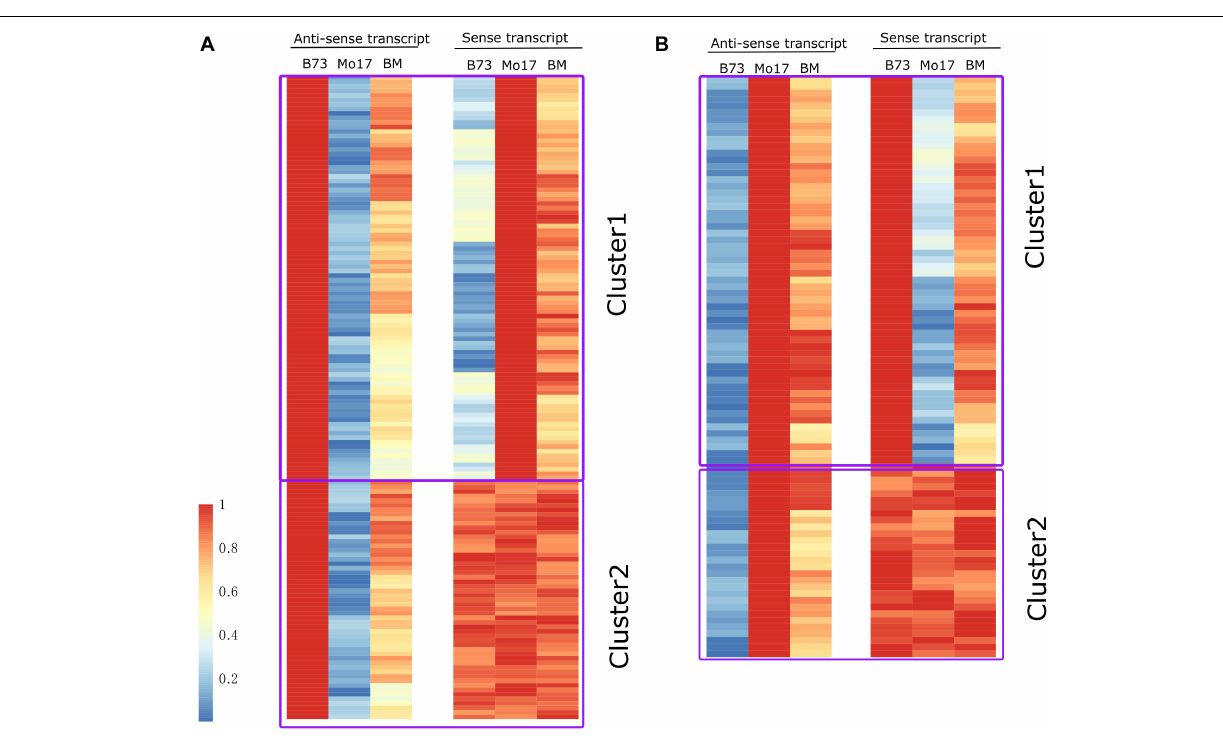
FIGURE 4 | Dynamic pattern of single-parent expression of anti-sense (SPEA) and its cognate sense RNA identified in leaf tissue in three genotypes (B73, Mo17, and BM). (A) Expression heatmap of SPEA_B and its cognate sense transcript in B73, Mo17, and BM. (B) Expression heatmap of SPEA_M and its cognate sense transcript in B73, Mo17, and BM. The fragments per kilobase per million (FPKM) value for anti-sense and sense transcript was normalized by their maximum observed FPKM. The red and blue colors represent the relatively high and low expression level. For SPEA_B in cluster 1 (A) , Pearson correlation coefficient (PCC) between anti-sense and sense transcript was -0.86 ( P < 1 × 10 − 21 ). For SPEA_M in cluster 1 (B) , PCC between anti-sense and sense transcript was -0.89 ( P < 1 × 10 − 18